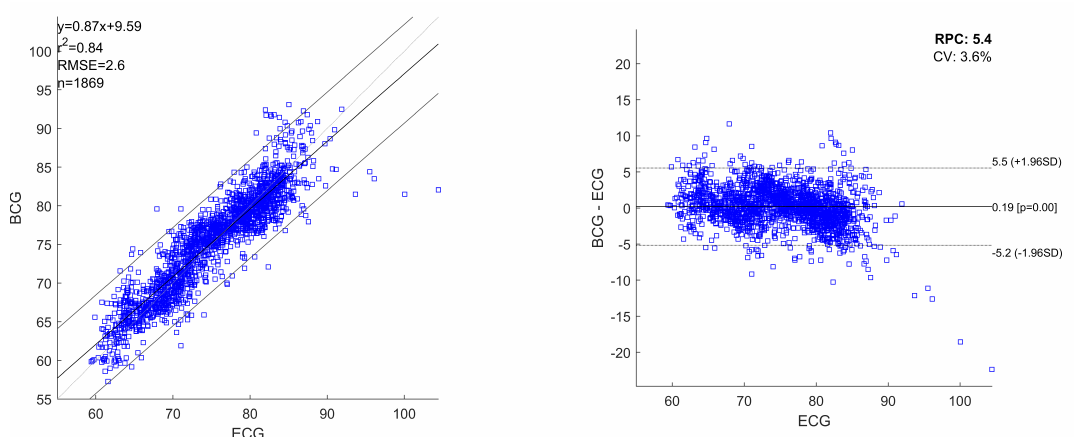
Figure A1. Linear regression plot and Bland-Altman plot of the analysed heartbeats for ECG and BCG considering the temporal lengths of 2 s for the epochs. The heartbeats are pooled over all the recordings. In the plots are reported: linear regression equation, squared Pearson r-value ( r 2 ), root mean squared error (RMSE), number of heartbeats analysed (n), reproducibility coefficient (RPC) and coefficient of variation expressed as a percentage (CV). The lines of mean of difference between ECG and BCG, and 95% limits of agreement are reported.